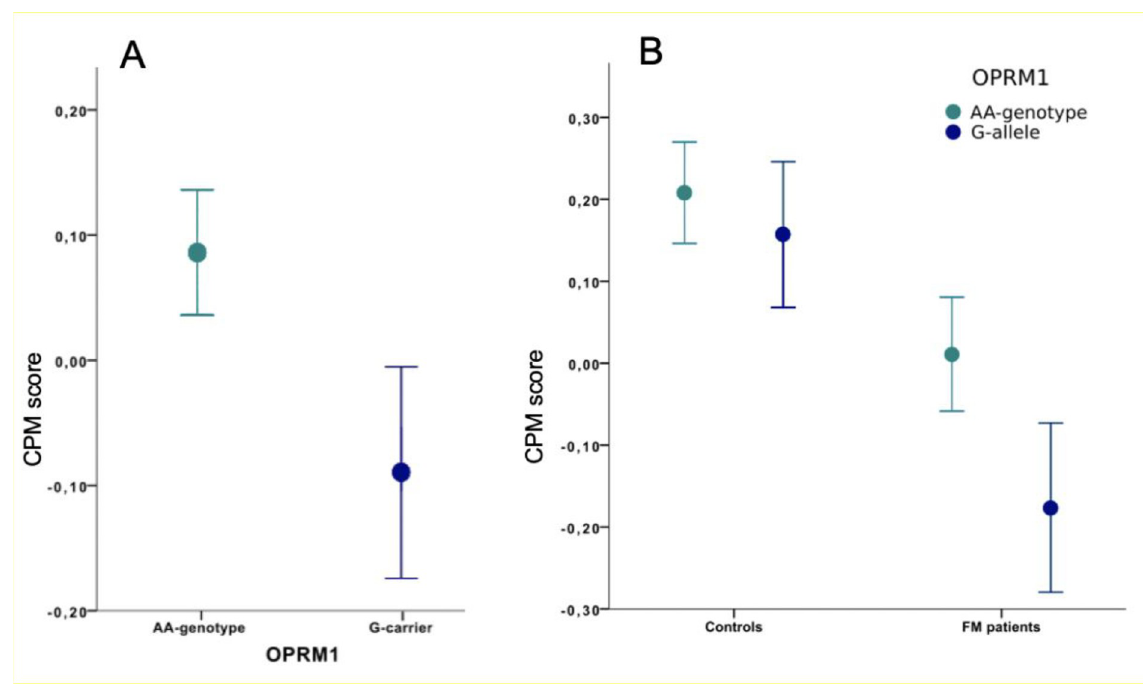
Fig 2. Conditioned pain modulation (CPM) score based on OPRM1 genotype in the study group. Fig 2A. Fibromyalgia patients and healthy controls pooled together split by OPRM1-AA versus G-genotype. Results showed significantly reduced CPM score in OPRM1 G-allele carriers (p = 0.019). Fig 2B. CPM score for HC and FM patients separately split by OPRM1-AA vs G-allele. A significant difference was seen for FM patients (p = 0.045) but not for HC. Notable, FM patients with the OPRM1 G-allele had the lowest CPM score among all four groups (indicating less efficient